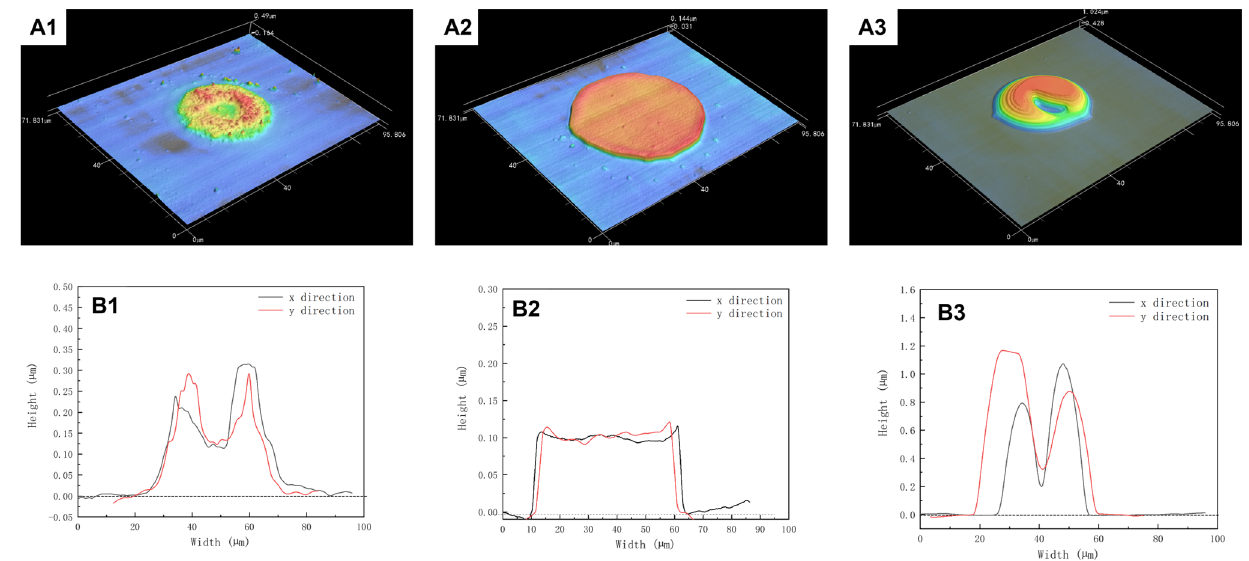
Figure 4. PDMS dots printed on sapphire substrate with different volume ratios. ( A1 – A3 ) 3D morphology image of PDMS dots, ( B1 – B3 ) PDMS dots’ cross section profile in the x-direction and y-direction. The volume ratio of decane from ( A1 – A3 ) is 20%, 50%, and 60%.